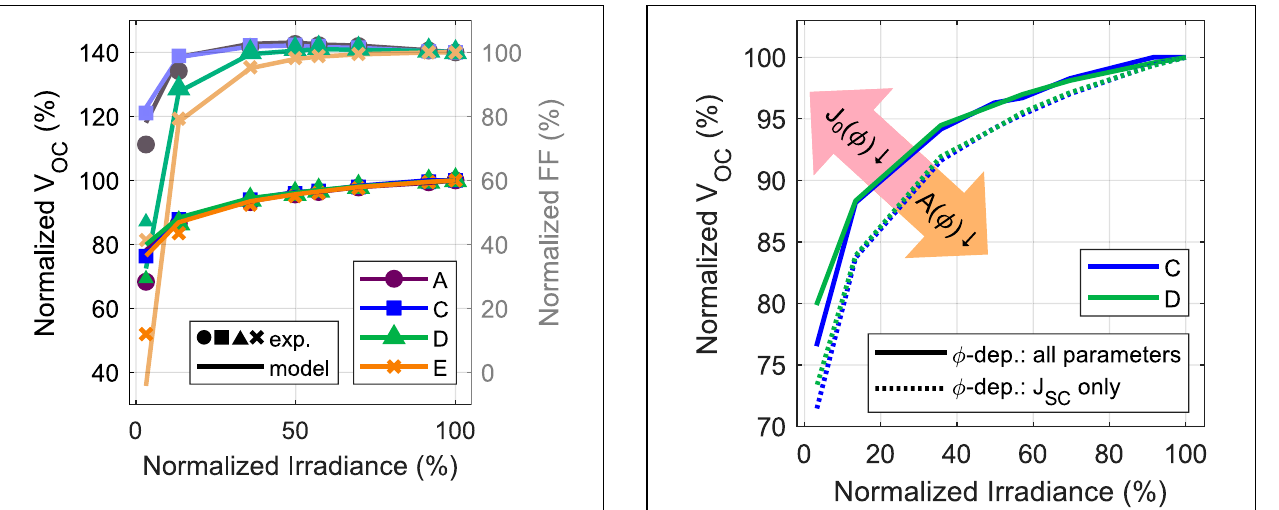
FIGURE 3 | Model quality: Comparison of the full model (lines) with the mean experimental data (symbols) of the 4 cell types (color-coded) for the V OC (left axis) and the FF (right axes).